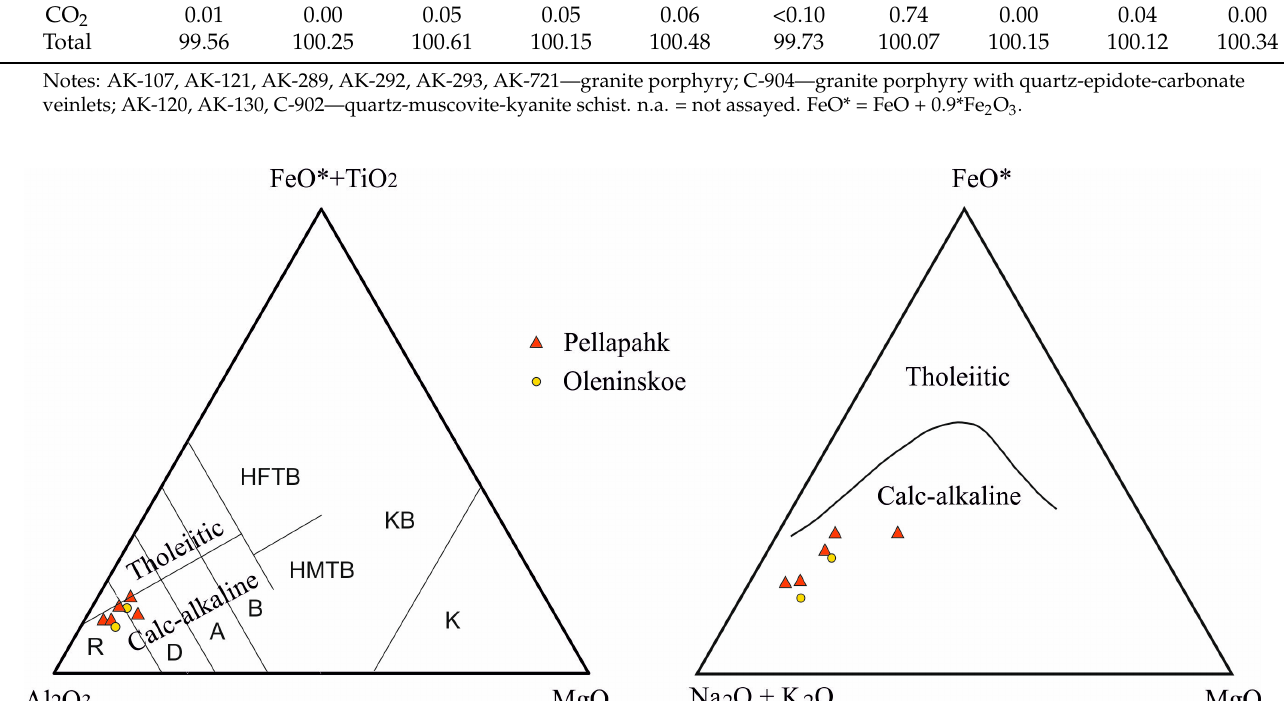
Table 1. Chemical composition (wt%) of granite porphyry and altered rocks of the Pellapahk intrusion.